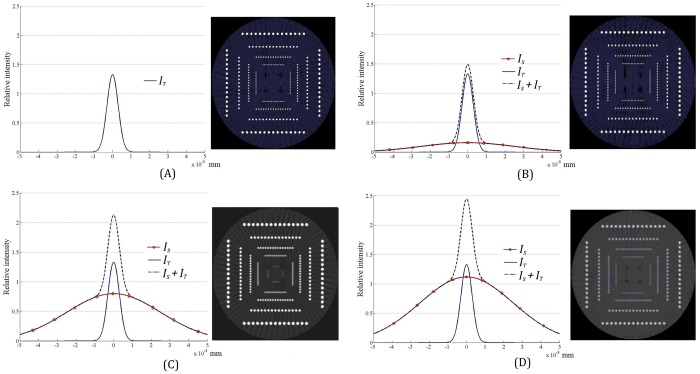
Effects of different IT / IS on the CT image resolution.(A) IS = 0; (B) IT / IS = 2, degradation of CT resolution isn’t obvious; (C)IT / IS = 1/2, degradation of CT resolution is tolerable; (D) IT / IS = 1/5, CT resolution degrades seriously. (Simulation CT image is 512×512 pixels).